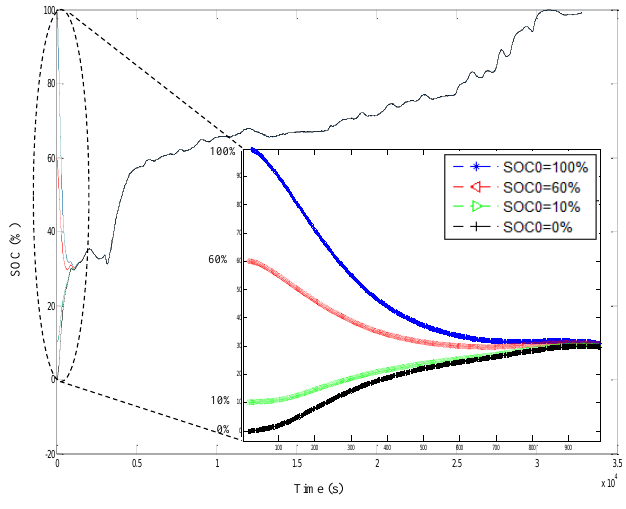
Figure 14. EKF algorithm convergence with random SOC 0